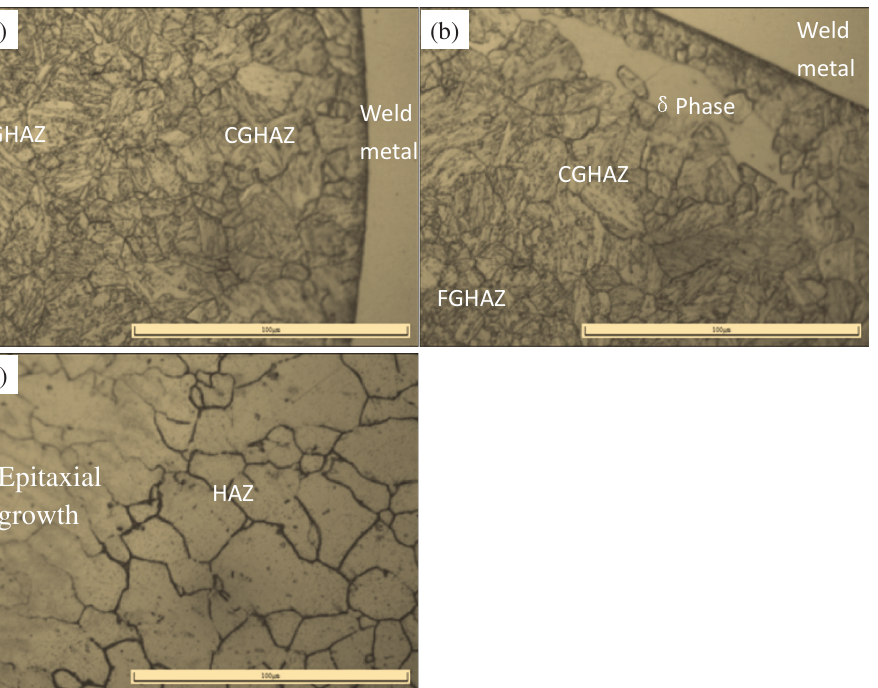
Figure 4: Microstructures of the fusion lines (a) between T92 and weld metal, (b) between T92 and weld metal, and (c) between Super 304H and weld